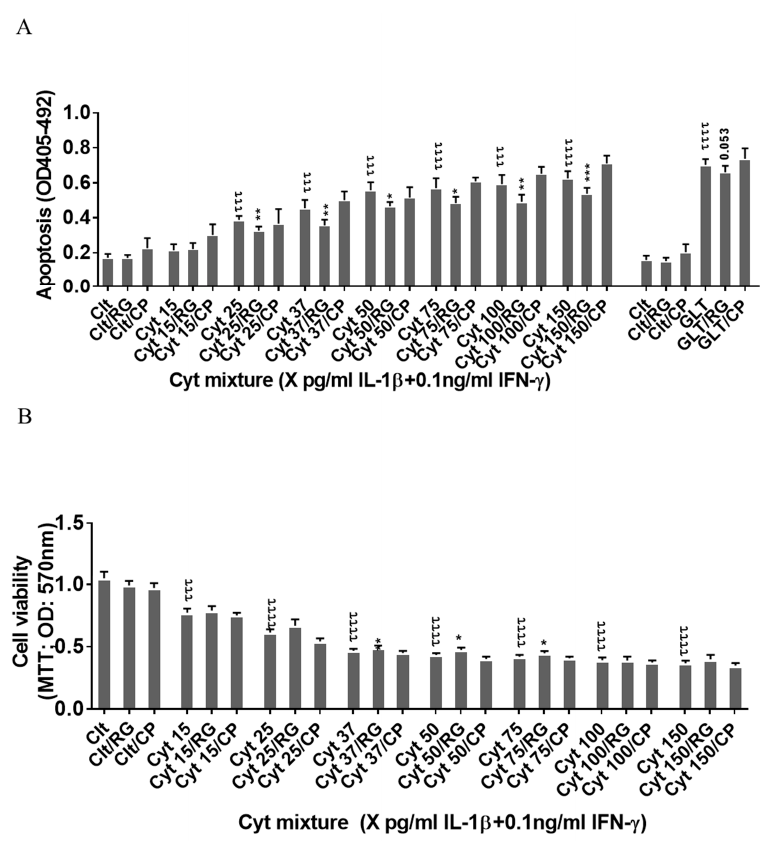
Figure 2. Rotigaptide ameliorates inflammation ‐ induced apoptosis associated with improved mitochondrial function in Cx43 ‐ deficient INS ‐ 1 cells. INS ‐ 1 cells were pre ‐ incubated with or without